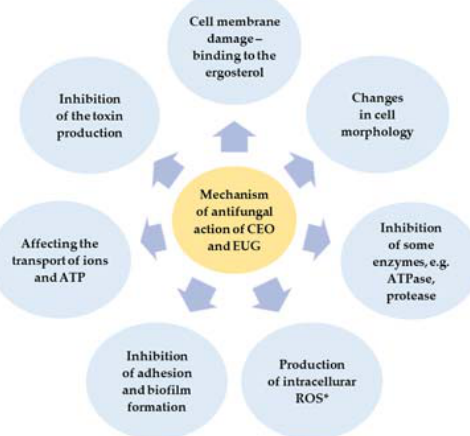
Figure 5. The mechanism of antifungal action of CEO and EUG (ROS*—Reactive Oxygen Species) (own elaboration based on [2,3,19,28,32–36]).